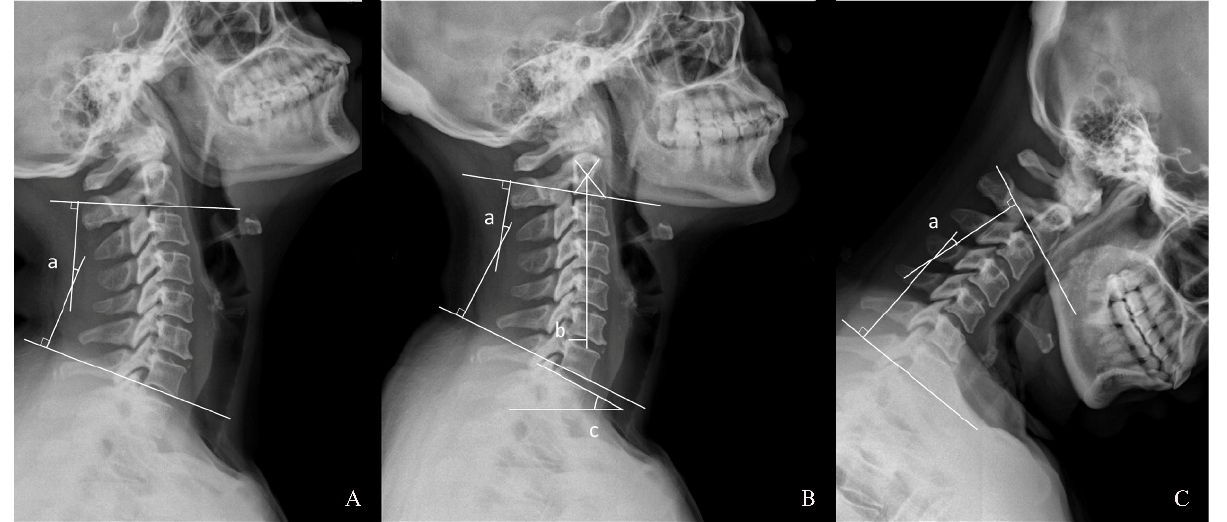
Figure 1 . Radiographic measurements: ( A ) extension, ( B ) cervical lateral and ( C ) flexion radiographs, a. C2–7 Cobb angle, b. C2–7 sagittal vertical axis (SVA) and c. T1 Slope (T1S).